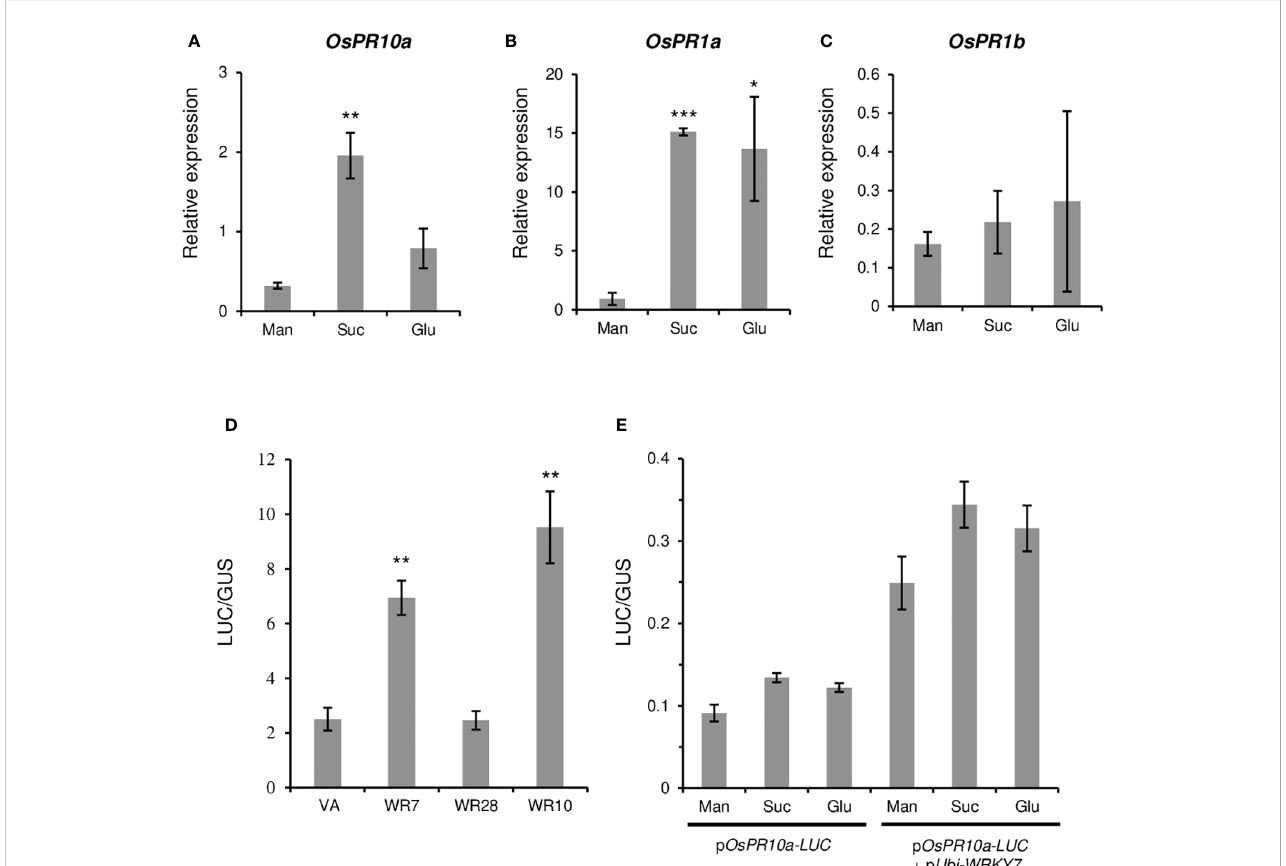
FIGURE 6 Effect of sugars and WRKY genes on the PR gene expression. (A-C) Effect of sugars on PR gene expression. Fourteen-day-old seedlings were grown in a hydroponic culture medium under constant light and they were transferred to the dark condition for two additional days before sucrose treatment. Mannitol, sucrose, or glucose were added at 3% fi nal concentration. After the treatment for 8 hours, expression levels of OsPR10a (A) , OsPR1a (B) , and OsPR1b (C) in roots were measured. Gene expression levels are relative to those of OsActin1 . Error bars indicate standard deviations; n = 3 or more. (D) Luciferase activity driven by the OsPR10a promoter. The p OsPR10a-LUC construct was transfected to Oc cell protoplasts alone (VA) or with p Ubi-OsWRKY7 (WR7), p Ubi-OsWRKY10 (WR10), or p Ubi-OsWRKY28 (WR28). The LUC activity was assayed 15 hours after transfection of the molecules. ZmUbi-GUS construct was used as an internal control in each combination. (E) Effect of sugars on the OsPR10a promoter activity. p OsPR10a-LUC alone or together with p Ubi-WRKY7 were transferred to Oc protoplasts and incubated in a culture medium containing mannitol (Man), sucrose (Suc) or glucose (Glu) at 3% fi nal concentration. Luciferase activity was measured 15 hours after transfection. ZmUbi-GUS construct was used as an internal control in each experiment. Error bars indicate standard deviations; n = 3. Statistical signi fi cance is indicated by *(P < 0.05), **(P < 0.01) and ***(P <